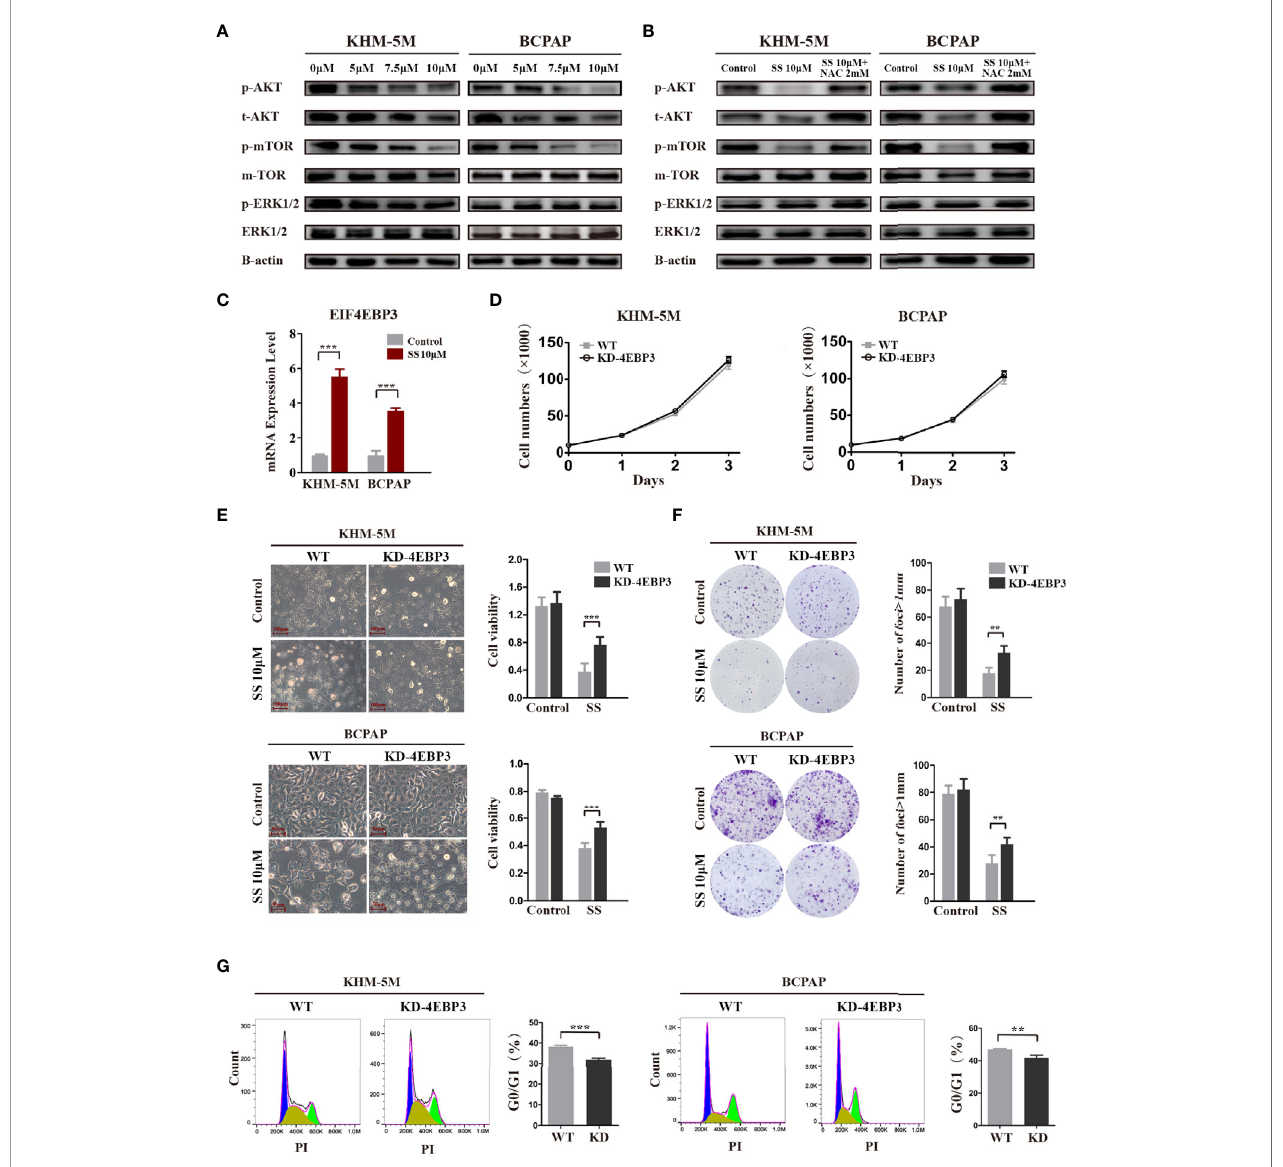
FIGURE 5 | SS inhibits the AKT/mTOR/4E-BP3 axis in a ROS-dependent manner. (A) Thyroid cancer cells were treated with vehicle control or different concentrations of SS for 6 h, and the protein levels of p-AKT, total AKT, p-mTOR, total mTOR, p-ERK, and total ERK were detected by western blotting. The expression of b -actin was used as a reference. (B) NAC treatment reversed the inhibitory effect of SS on the AKT/mTOR pathway. (C) 4E-BP3 mRNA expression in SS treatment and control groups. (D) The proliferation of WT and 4E-BP3-knockdown cells under normal conditions. (E) Morphological changes, cell viability, and (G) percentage of G0/G1 phase cells in WT and 4E-BP3-knockdown groups after incubation with SS for 24 h. (F) Colony formation capacity of WT and 4E-BP3- knockdown cells after SS treatment. SS, sodium selenite; NAC, N-acetylcysteine. **P < 0.01; ***P <